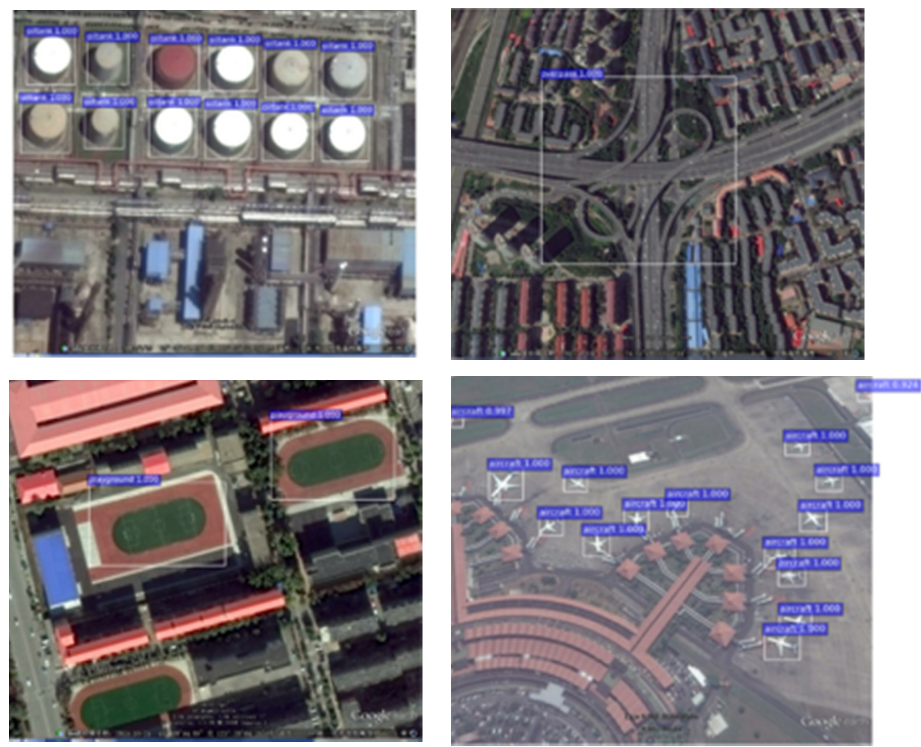
Figure 6. The results of some detected objects from RSOD.